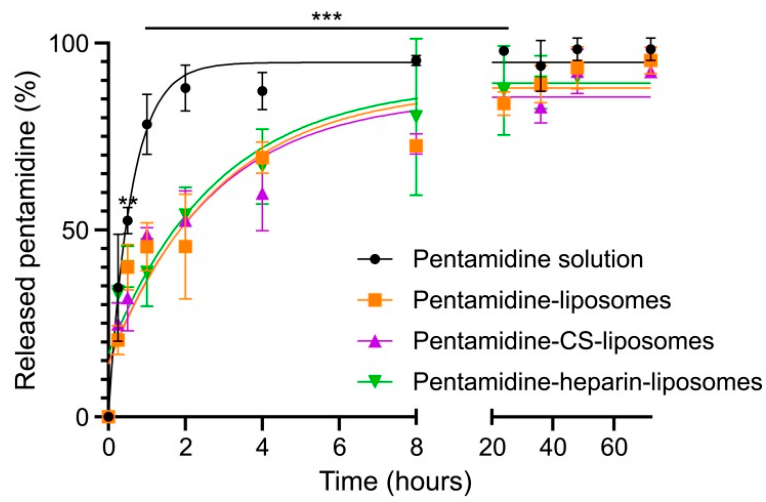
Figure 4. Amount of pentamidine (%) released from dialysis bags along 72 h of incubation in PBS. Mean values ± standard deviations (error bars) are reported ( n = 3). **: p ≤ 0.01; ***: p ≤ 0.001 (relative to free pentamidine solution).